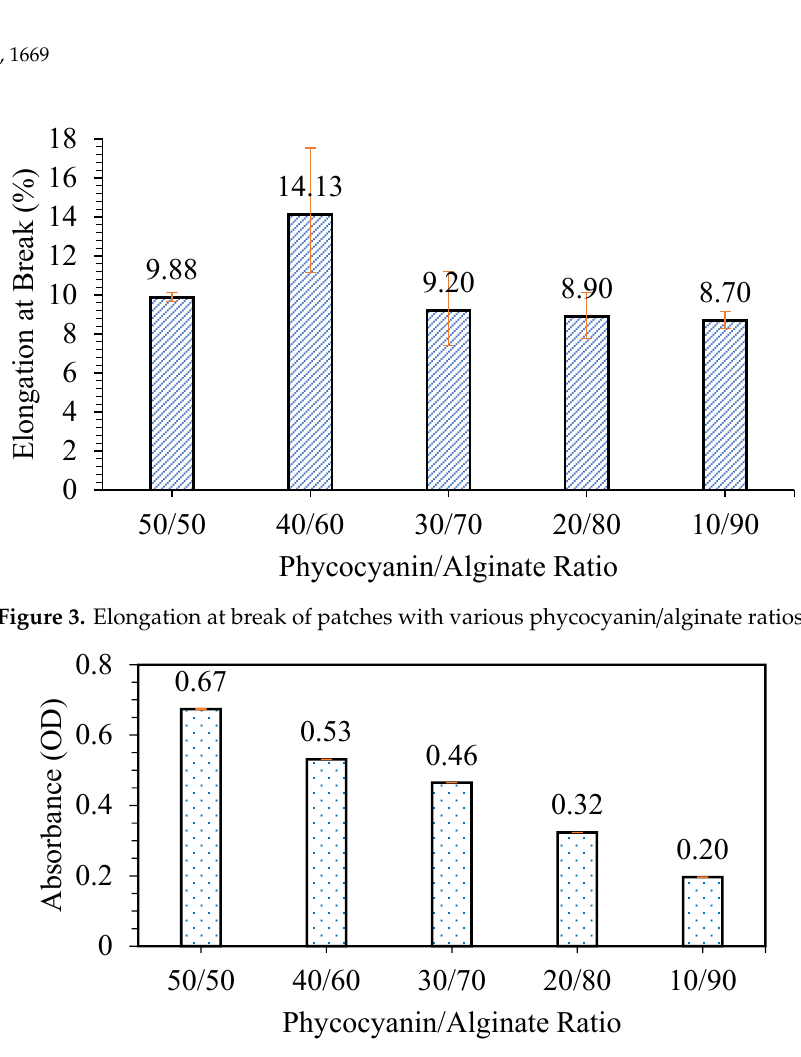
Figure 4. Releasing test of patches with various phycocyanin / alginate ratios.